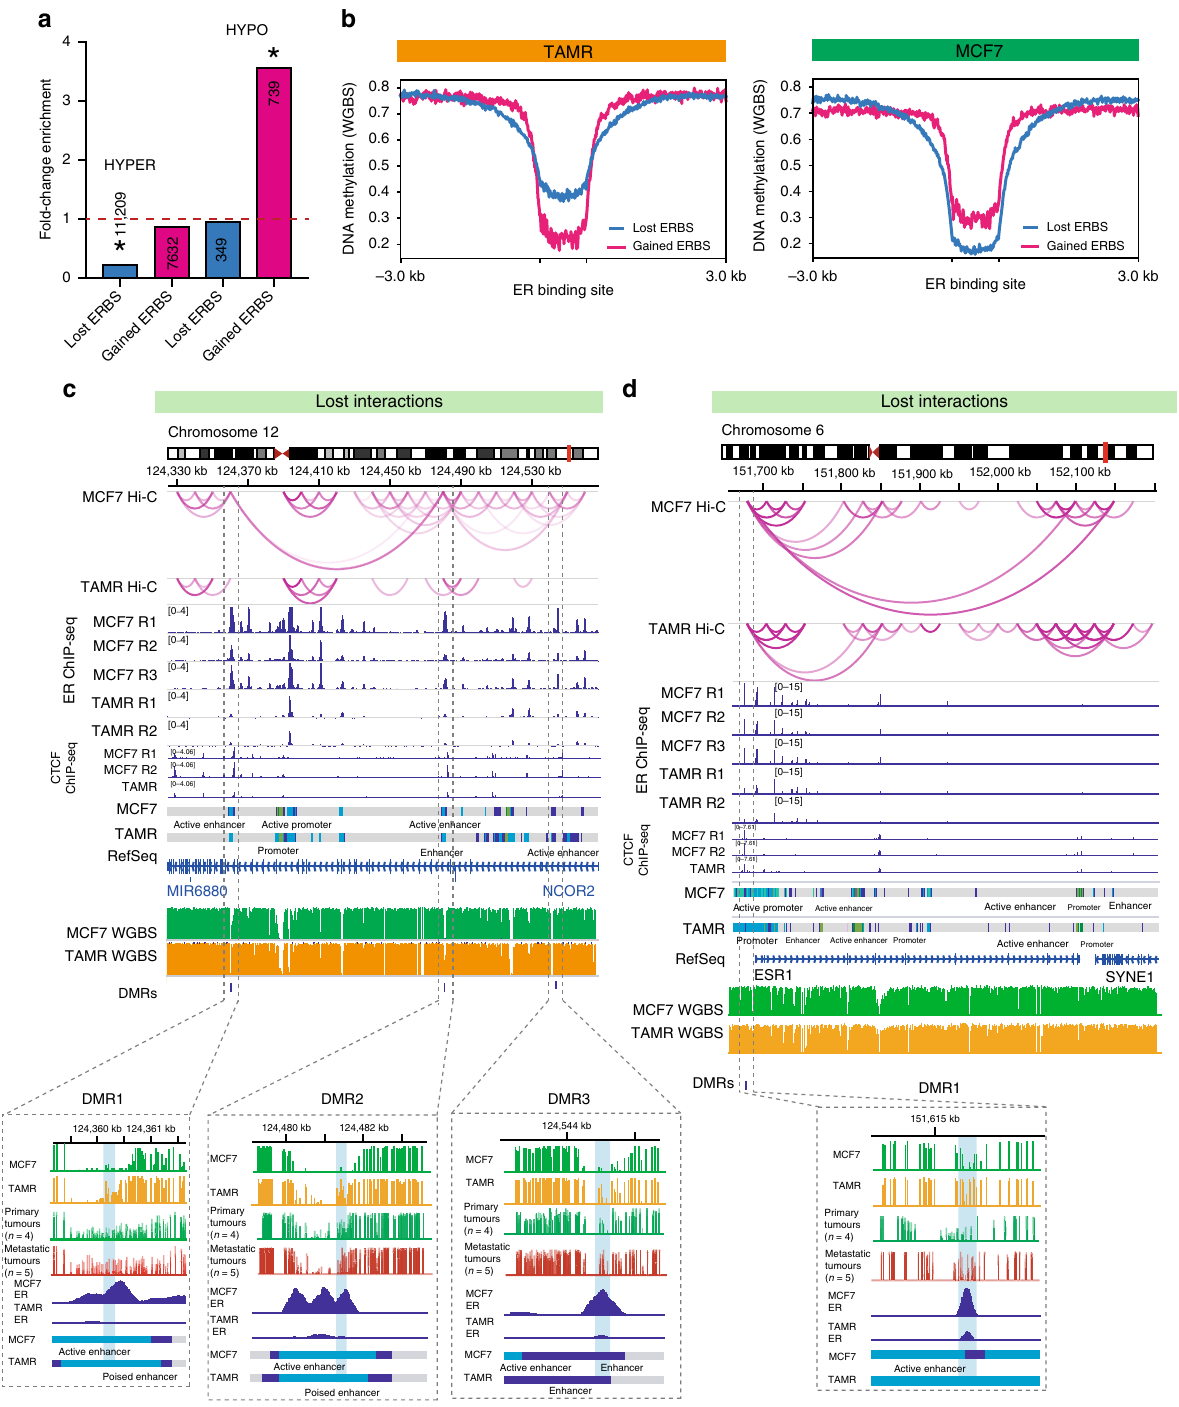
Fig. 4 Methylation associates with loss of ER binding and loss of interactions. a Fold-change enrichment of differentially methylated regions (DMRs), which are hyper- or hypomethylated in TAMR cells as compared to MCF7 cells for ER binding sites (ERBS). * P value < 0.001. b Average pro fi le plot showing methylation in TAMR (left panel) and MCF7 (right panel) around ER binding sites (ERBS) gained (pink) or lost (blue) in TAMR cells as compared to MCF7 cells. c Representative example showing loss of ER-bound interaction in TAMR cells at NCOR2 gene associated with DNA hypermethylation. Three differentially methylated regions (DMRs) that are present at ER-enhancer regions are associated with loss of ER binding and loss of interactions in TAMR cells. DNA hypermethylation at the anchors of lost differential interaction, overlapping region of ER binding in MCF7 cells can be observed in metastatic ER + breast cancer patient tumour samples ( n = 5) as compared to primary tumours ( n = 4). d Representative example showing loss of ER-bound interaction in TAMR cells at ESR1 gene associated with DNA hypermethylation. Differentially methylated region (DMRs) at the ER-enhancer is associated with loss of ER binding and loss of interactions in TAMR cells. DNA hypermethylation at the anchor of lost differential interaction, overlapping a region of ER binding in MCF7 cells can be observed in metastatic ER + breast cancer patient tumour samples ( n = 5) as compared to primary tumours ( n =